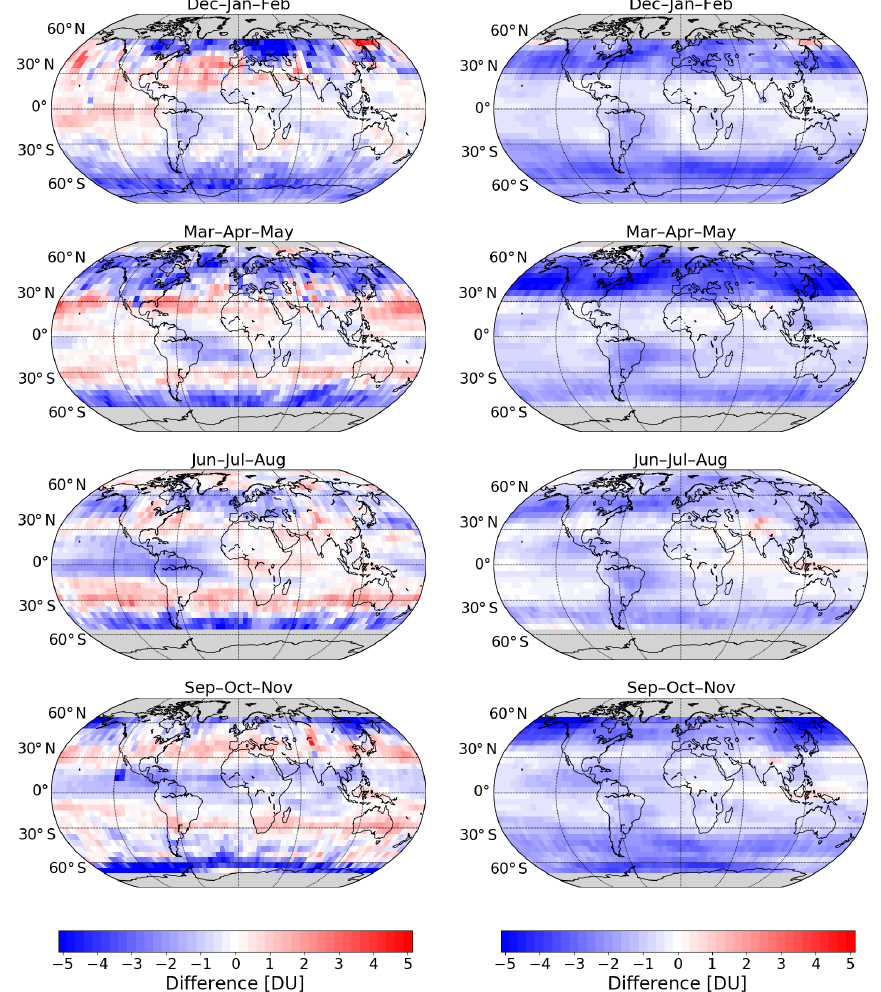
Figure 8. Seasonal mean absolute difference in monthly standard deviation between adjusted MERRA-2 and GTO-ECV. From top to bottom: December–February, March–May, June–August, and September–November. Panels on the left-hand side correspond to the period 1995– 2004, and panels on the right-hand side correspond to the period